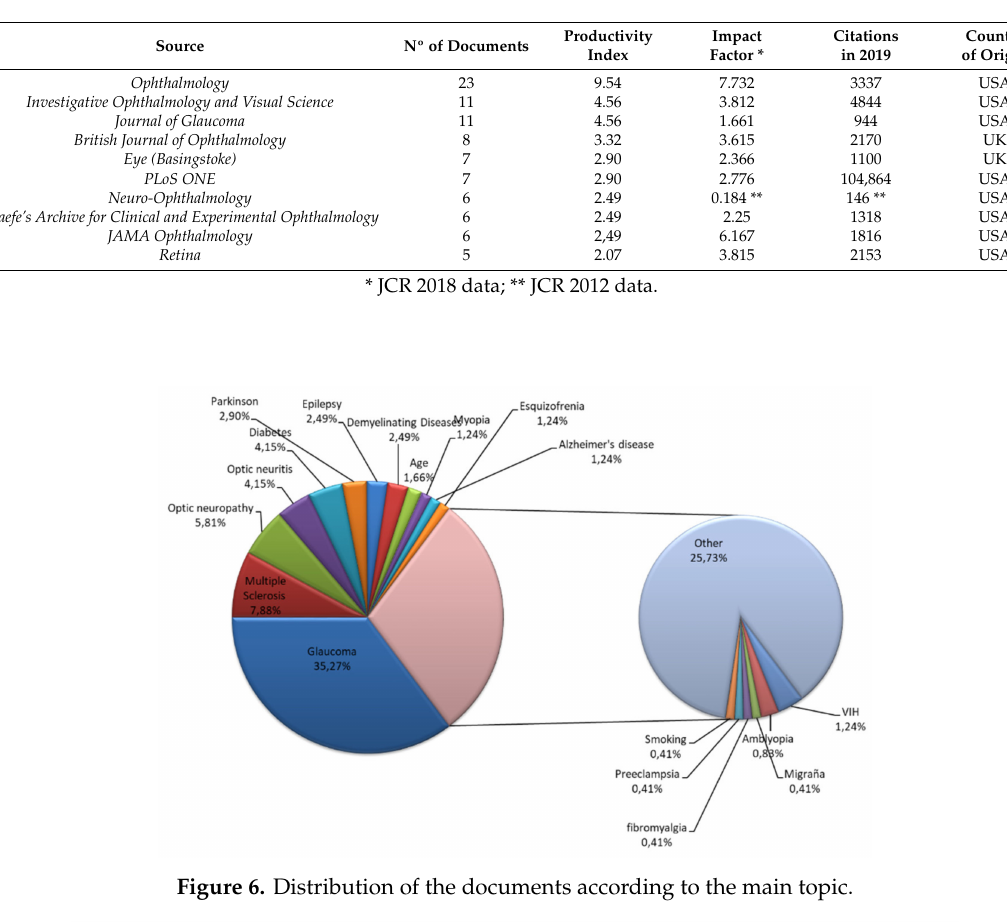
Table 5. Journals with highest number of publications on optical coherence tomography retinal thickness measurements.